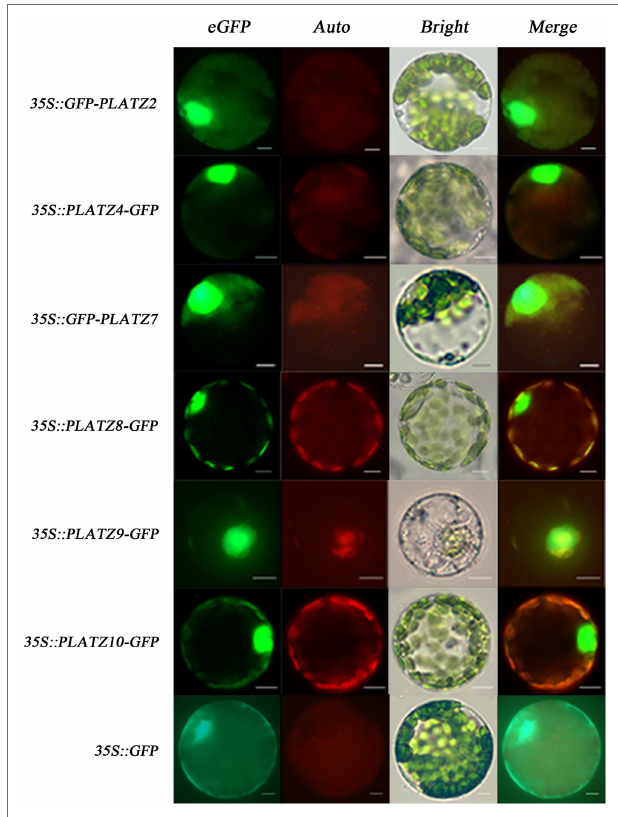
FIGURE 8 | The subcellular localization of GbPLATZ proteins in ginkgo. The fusion location of the GFP gene sequence is shown on the left. Scale bars = 10 μ